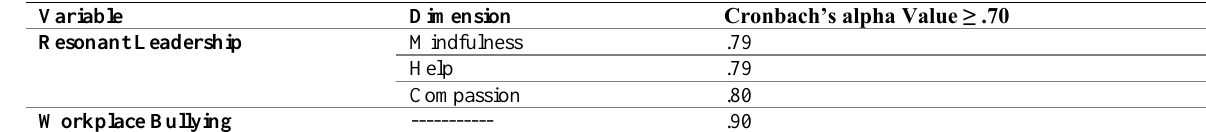
Table 9: Reliability Test Results of the Measurement Instrument (n=45)